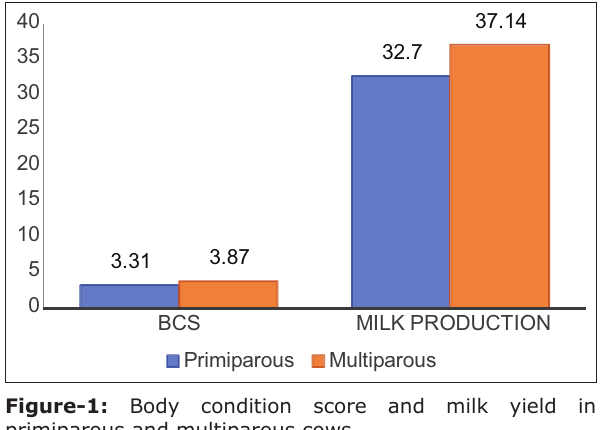
Figure-1: Body condition score and milk yield in primiparous and multiparous